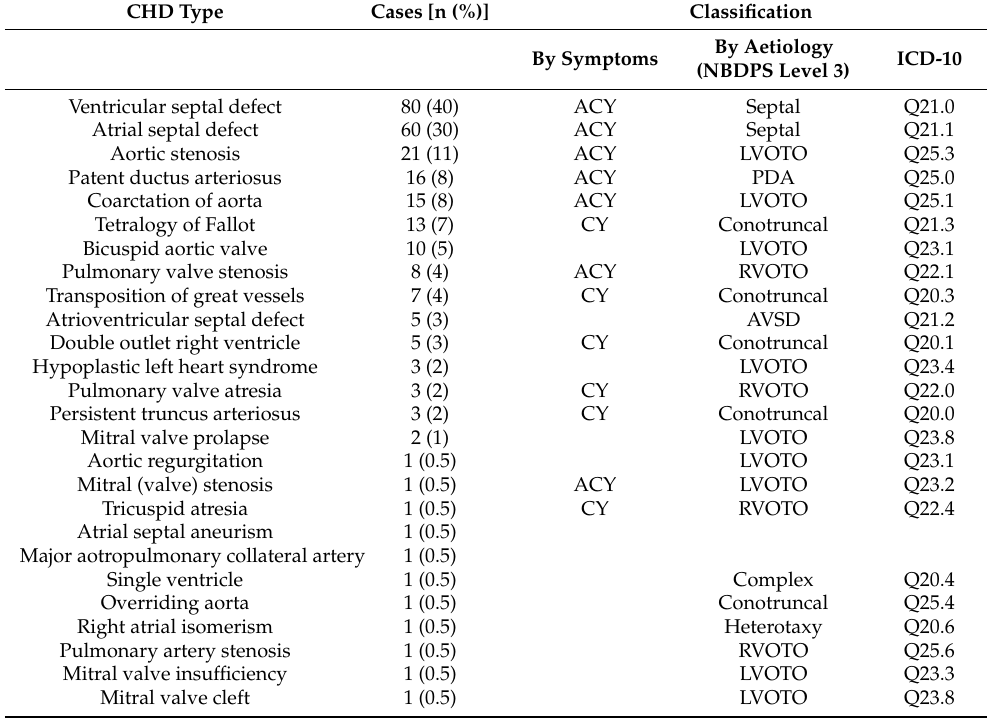
Table 1. Classification of the study cohort by CHD symptoms and etiology, and according to ICD- 10 (WHO 2016). ACY, acyanotic; CY, cyanotic; NBDPS, National Birth Defect Prevention Study (CDC coordinated USA nationwide study); LVOTO, left ventricular outflow tract obstruction; PDA, patent ductus arteriosus; RVOTO, right ventricular outflow tract obstruction; AVSD, atrioventricular septal defect; Q20, congenital malformations of the cardiac chambers and connections; Q21, congenital malformations of the cardiac septa; Q22, congenital malformations of the pulmonary and tricus- pid valves; Q23, congenital malformations of the aortic and mitral valves; Q24, other congenital malformations of the heart; Q25, congenital malformations of the great